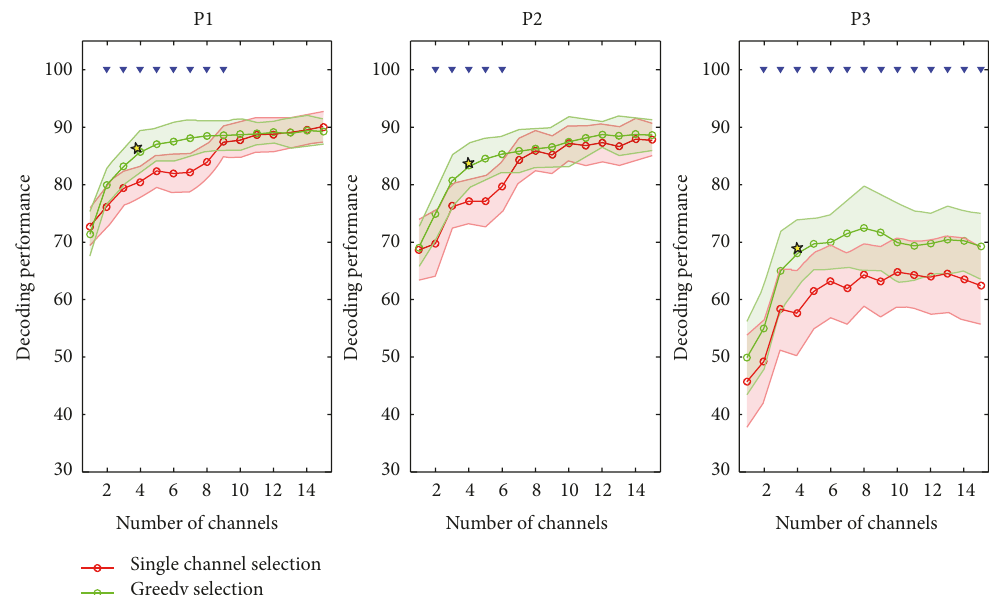
Figure 4: The decoding performance varies as a function of the number of channels. The green curves represent the decoding performance using the channels selected by greedy selection, and the red curves represent the result of the channels selected by single channel selection. The performance of greedy selection signi fi cantly yields higher performance than that of single channel selection when the same number of channels was used. The upside-down triangles indicate that the greedy selection performance is signi fi cantly higher than the single channel selection performance. The yellow stars indicate that the decoding performance obtained from the channel subset reaches the saturated point in the greedy selection. No signi fi cant improvement of decoding performance was found after adding more channels into the